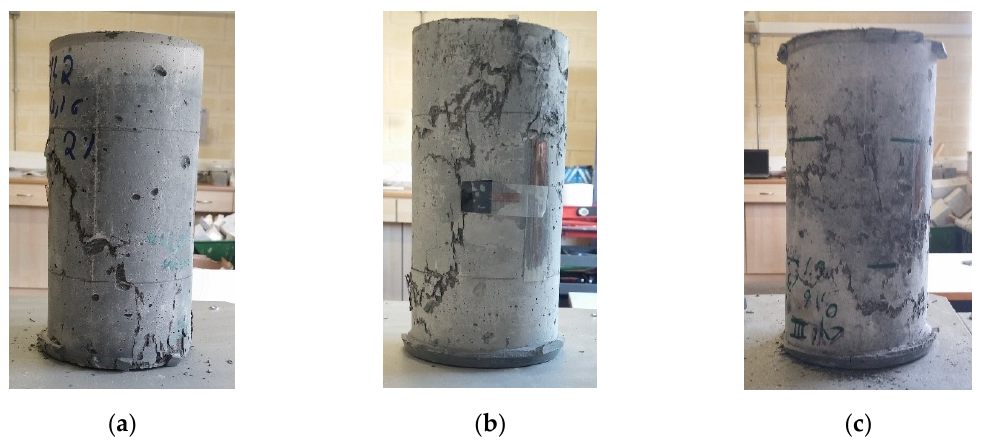
Figure 11. Stress–strain in compression for UHPFRC-influence of fibre content and length.